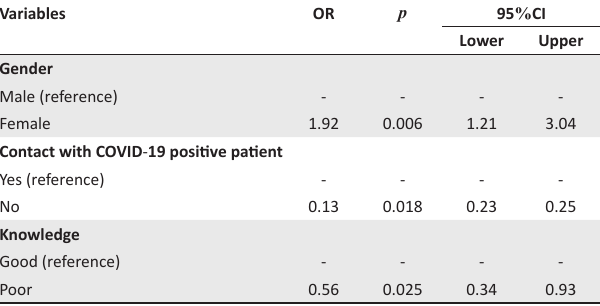
TABLE 4: Logistic regression for psychological distress and selected